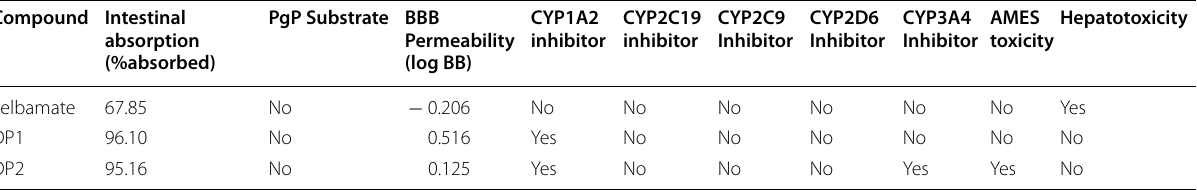
Table 5 ADMET predictions by pkCSM Compound Intestinal